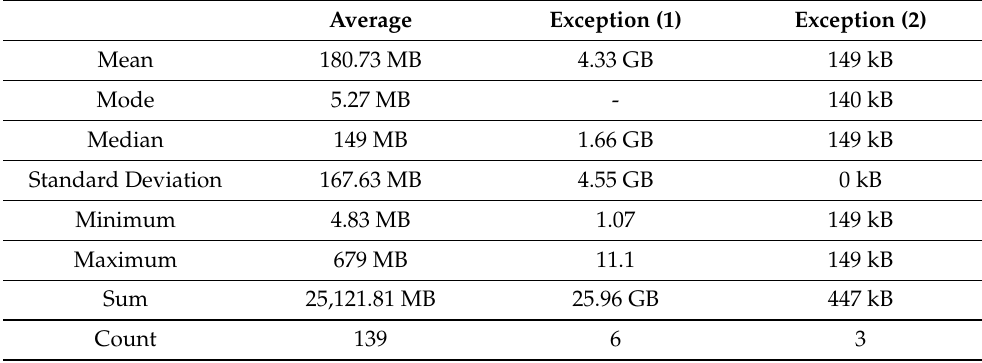
Table 3. Cindy Space